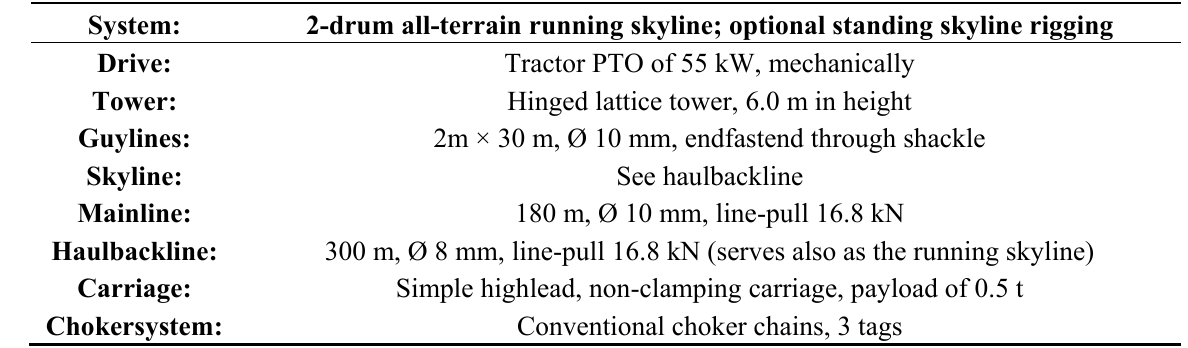
Table 2. Technical specifications of the Igland Hauler